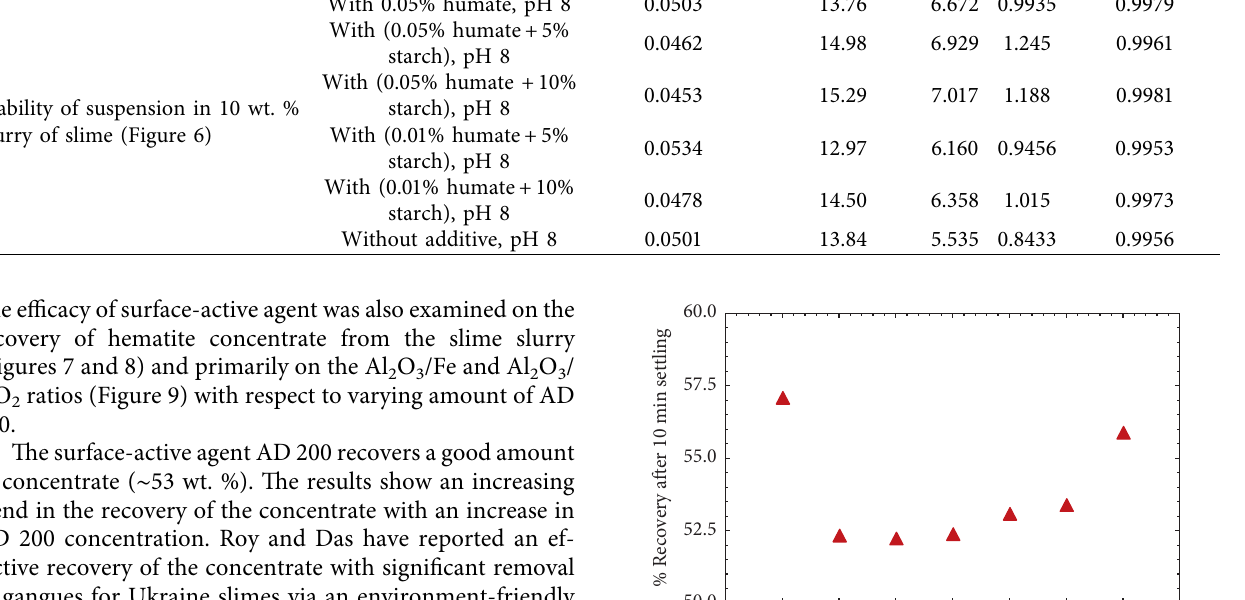
Goodness of fit ( R 2 )